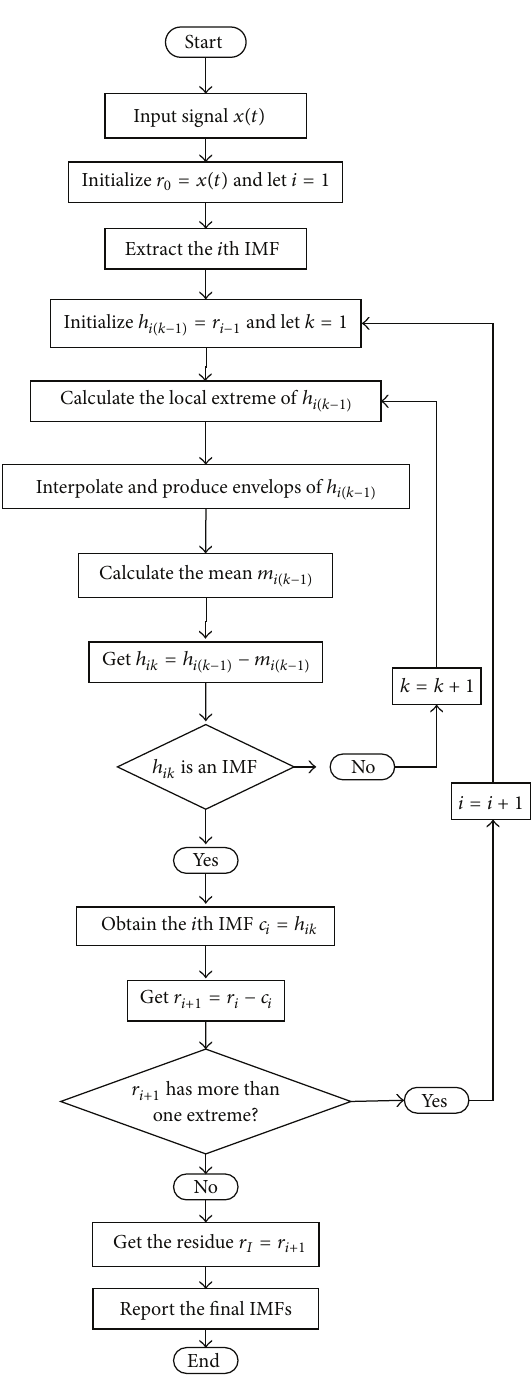
Figure 1: Flow chart of